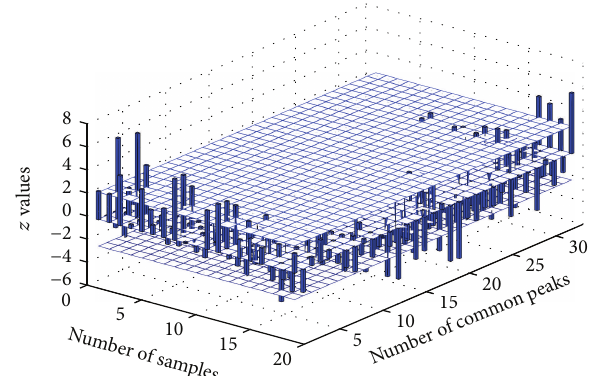
Figure 5: 𝑧 values of common peaks in 19 batches of samples having significant differences based on Mahalanobis distance analysis. The blue bars represent the 𝑧 values of 33 common peaks. 𝑧 crit plane is based on the 𝑡 crit value given by 𝑡 -test at 95% confidence level ( 𝛼 = 0.05 ).